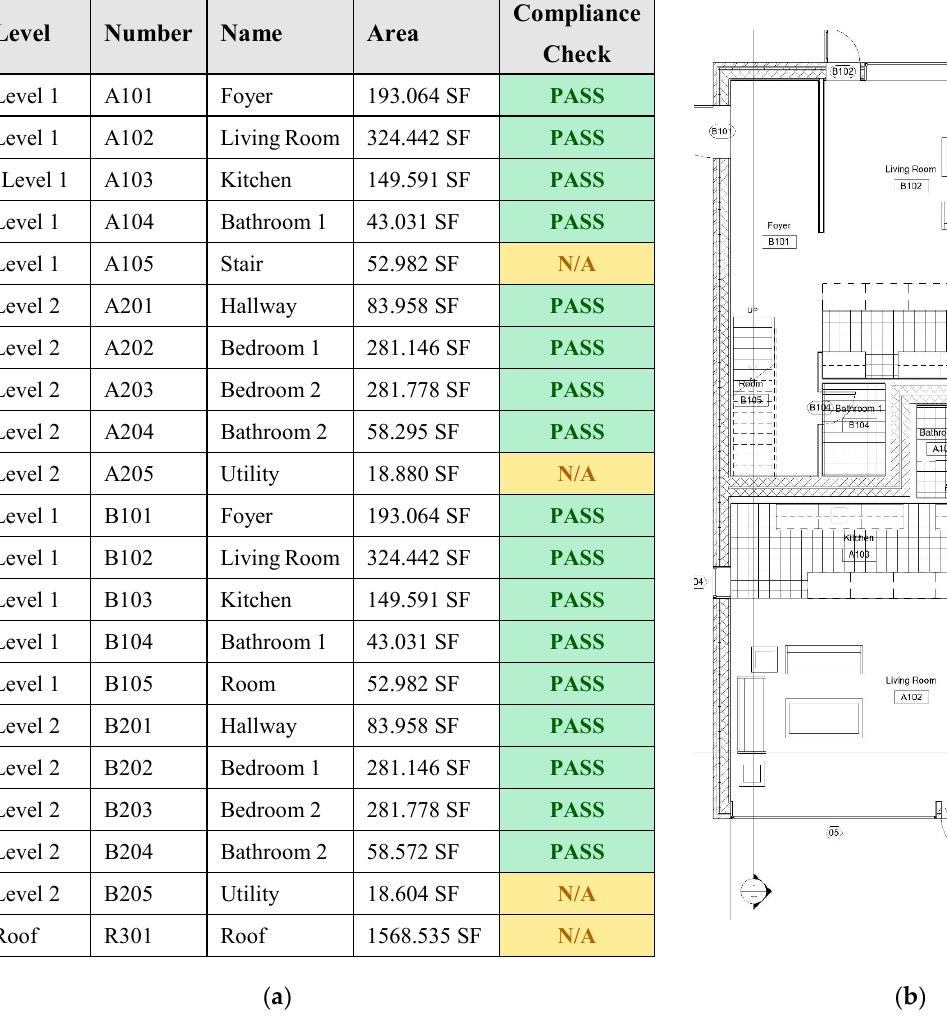
Figure 12. Results example of checking compliance with the space areas regulations of FBC 2017-R. ( a )ACCC results; ( b )Floor plan of level 1 of the case study model.